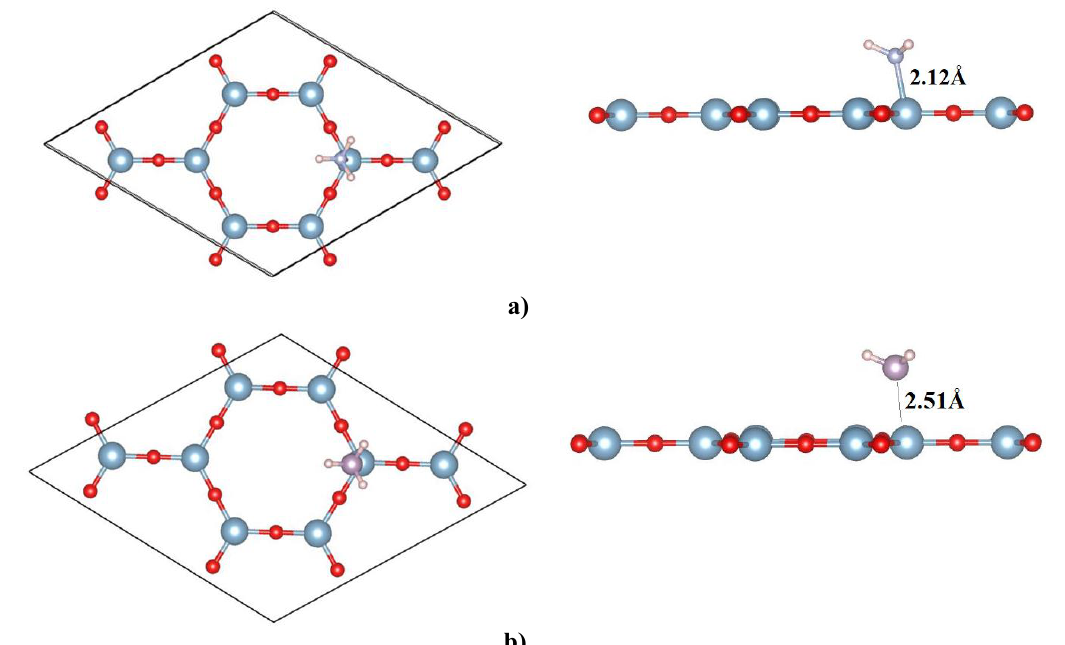
Fig. 2. Top and side-view of a) NH